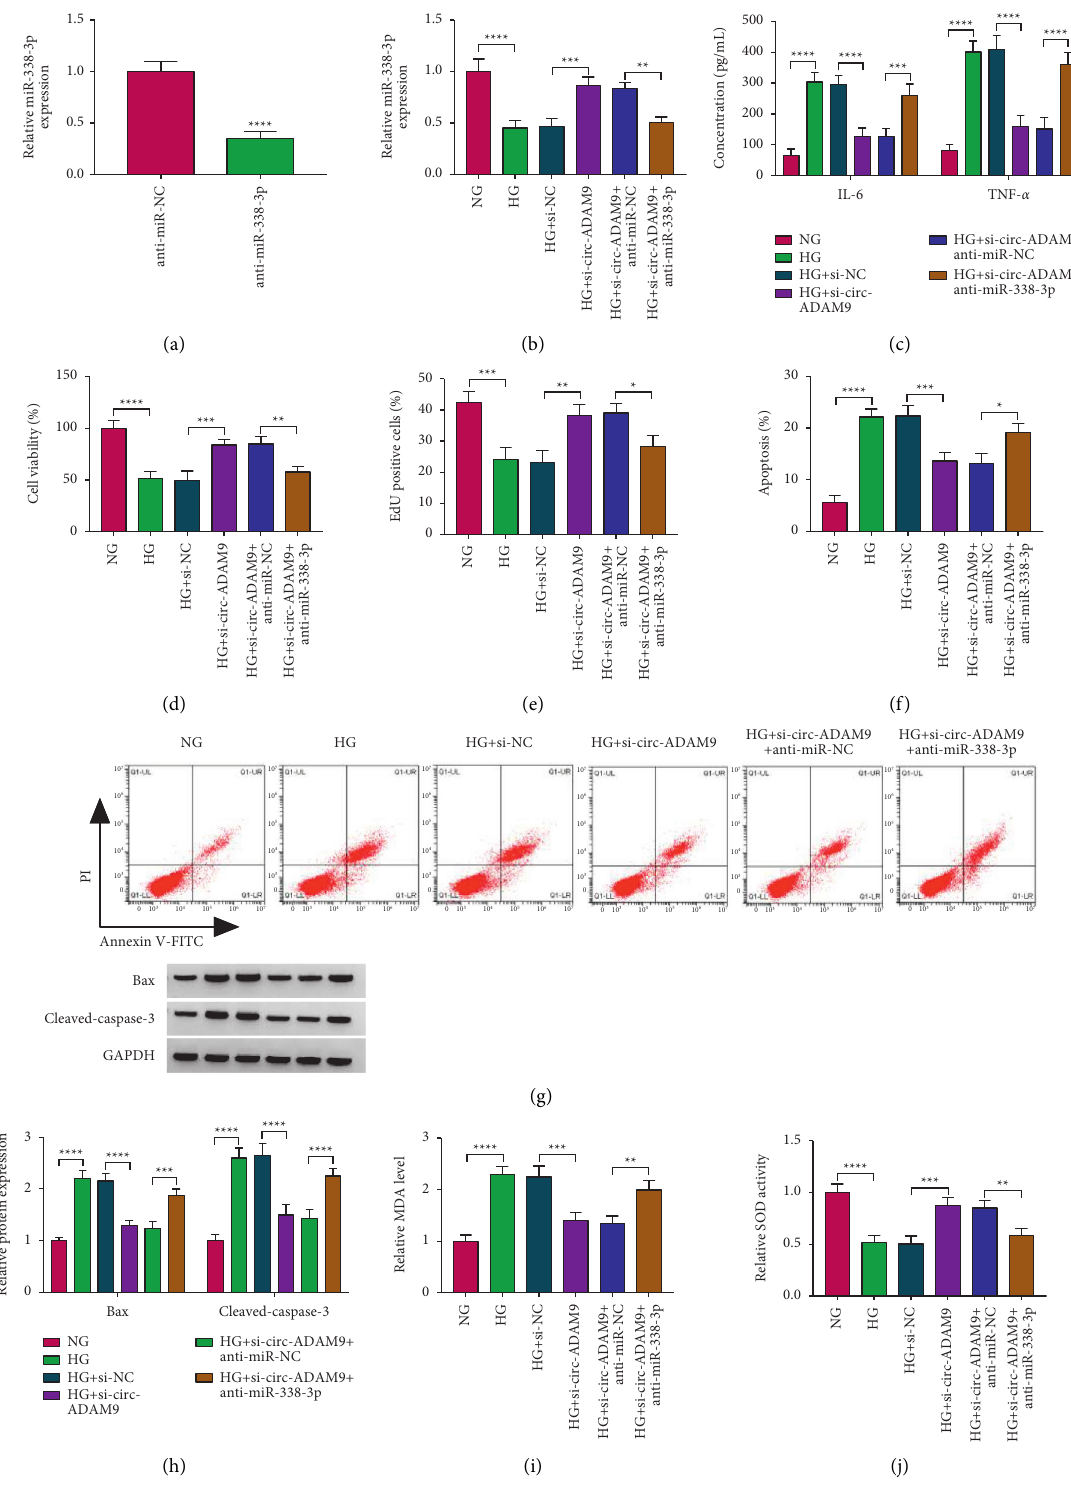
Figure 4: Effects of si-circ-ADAM9 and anti-miR-338-3p on HG-induced ARPE-19 cell injury. (a) The transfection efficiency of anti-miR- 338-3p was assessed by detecting miR-338-3p expression. (b–j) ARPE-19 cells were transfected with si-NC, si-circ-ADAM9, si-circ- ADAM9+anti-miR-NC, or si-circ-ADAM9 +anti-miR-338-3p and then treated with HG. The cells treated with NG were used as control. (b) The expression of miR-338-3p was determined using qRT-PCR. (c) The concentrations of IL-6 and TNF- α were determined by ELISA. MTTassay (d), EdU assay (e), and flow cytometry (f, g) were measured to assess cell proliferation and apoptosis. (h) The WB analysis was performed to detect the protein expression of Bax and cleaved-caspase-3. (i-j) MDA level and SOD activity were analyzed to evaluate cell oxidative stress. ∗ P < 0 . 05, ∗∗ P < 0 . 01, ∗∗∗ P < 0 . 001, and ∗∗∗∗ P < 0 .